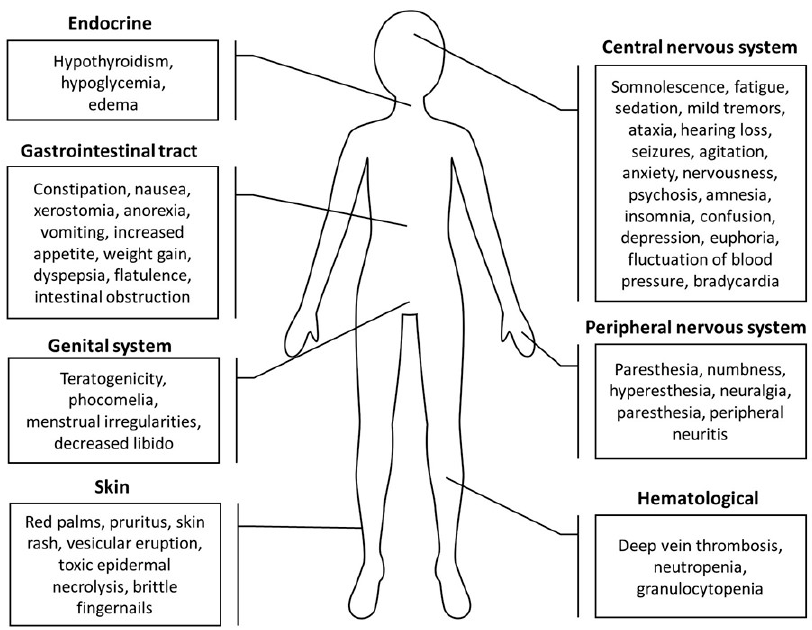
Figure 3. A summary of thalidomide side effects on the skin, gastrointestinal tract, central and peripheral nervous systems, genital system, endocrine system, and hematological system [72,156,158,159].